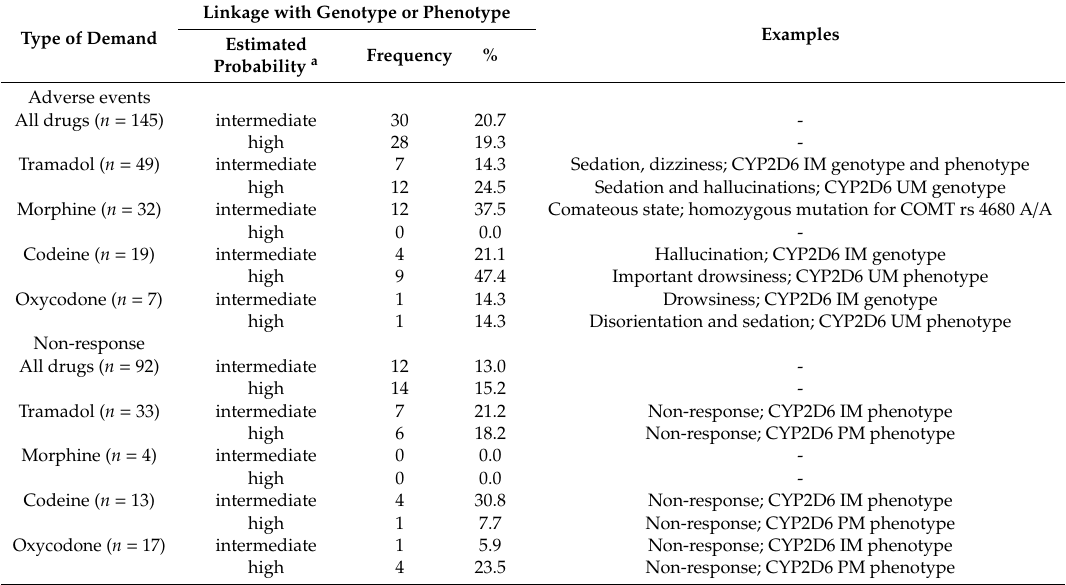
Table 6. Link between the type of demand and patient genotype or phenotype by specific drug.